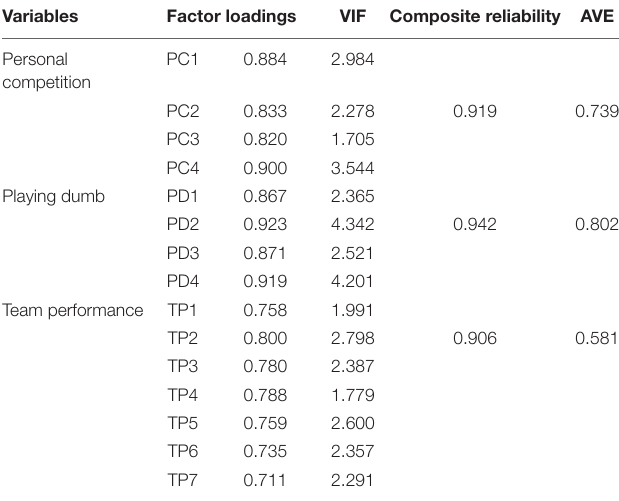
TABLE 3 | Measurement model.